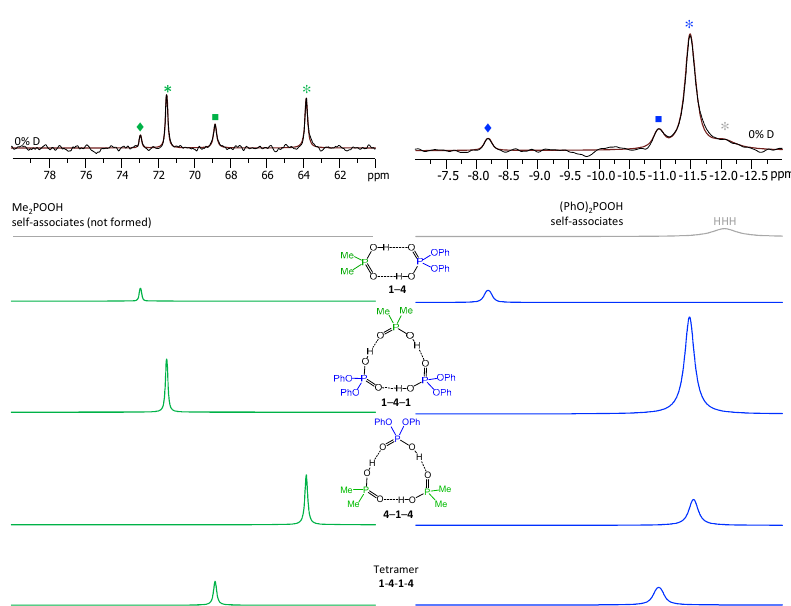
Figure 8. The parts of 31 P NMR spectrum of the sample containing acids 1 and 4 (1.2:1) in CDF 3 /CDF 2 Cl at 100 K. The experimental spectrum is deconvoluted into the sub-spectra arising from self-associated of 1 or 4 , heterodimer 1 - 4 , two heterotrimers, 1 - 4 - 1 and 4 - 1 - 4, and a tetramer, consisting of two molecules of 1 and two molecules of 4 in an alternating fashion 1 - 4 - 1 - 4 . For visual clarification the signals in the experimental spectrum and the computed sub-spectra are color coded. Trimers, dimers, and tetramers are marked by asterisks, diamonds, and squares, respectively. Table 1. The 1 H - NMR chemical shifts of bridging proton in various isotopologs of homodimers and heterodimers of POOH-containing acids 1 – 4 in CDF 3 /CDF 2 Cl at 100 K. The corresponding spectra are shown in Figures 3, 5, 7, 9, and 10 and Figures S1, S3, S5, S8, and S9.